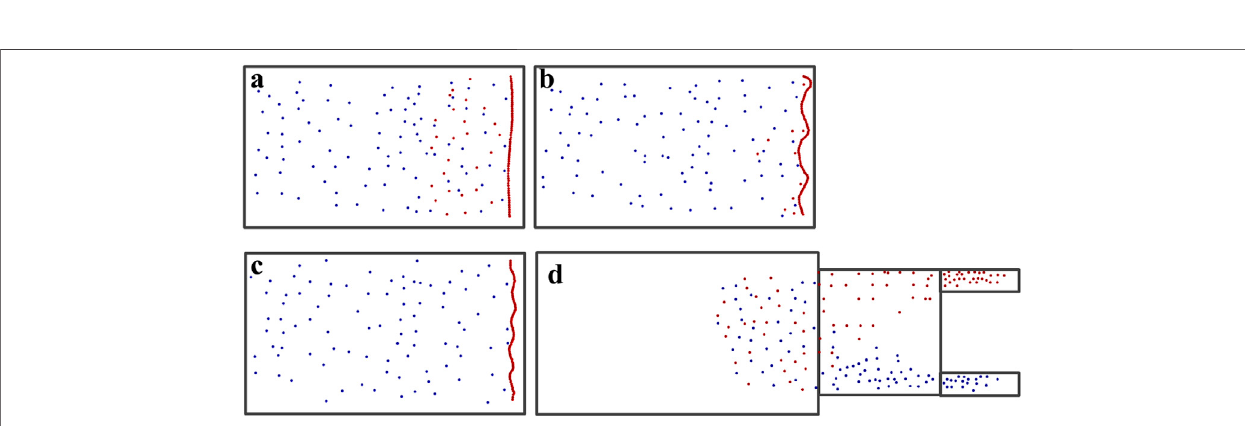
the same sphere radius a = 10nm, and the refractive index of fl uid media is n m = 1.33 (water). The refractive indices of particles are n ph = 1.59 (red), n pl = 1 (blue), respectively. There are 180 spheres in total, and each color has 90 spheres. In Figure 2 , the sorting platform is put in the focal plane of the lens. When the beam is fi xed, we move the platform, and the particles with a higher refractive index can be arranged to move with the beam stably. Thus, two kinds of particles can be sorted. Figure 2 shows how the unwound circular and polygonal OV beams are used to sort particles. In Figure 2 A, 26 red spheres are missed by the sorting process (see Supplementary Movie S1 ). The sorting ef fi ciency of this beam approaches 71.1%. In Figure 2B , there are 10 particles left unsorted (see Supplementary Movie S2 ) with an increasing ef fi ciency of 88.9%. In Figure 2C , all the particles are sorted successfully (see Supplementary Movie S3 ). In this case, the sorting ef fi ciency reaches 100%. From Figure 2 , one can see that the unwound polygonal OV beams sort more particles